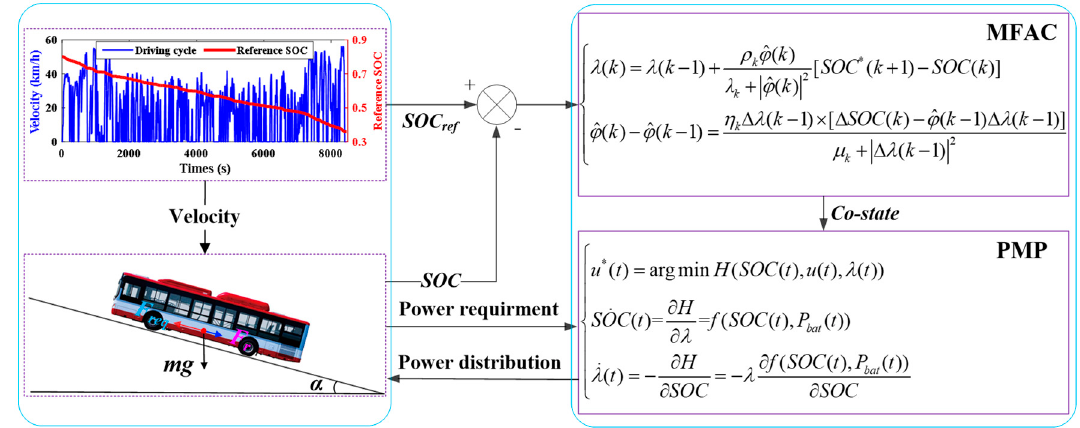
Figure 16. Scheme of Pontryagin’s minimum principle (PMP)-based energy management.